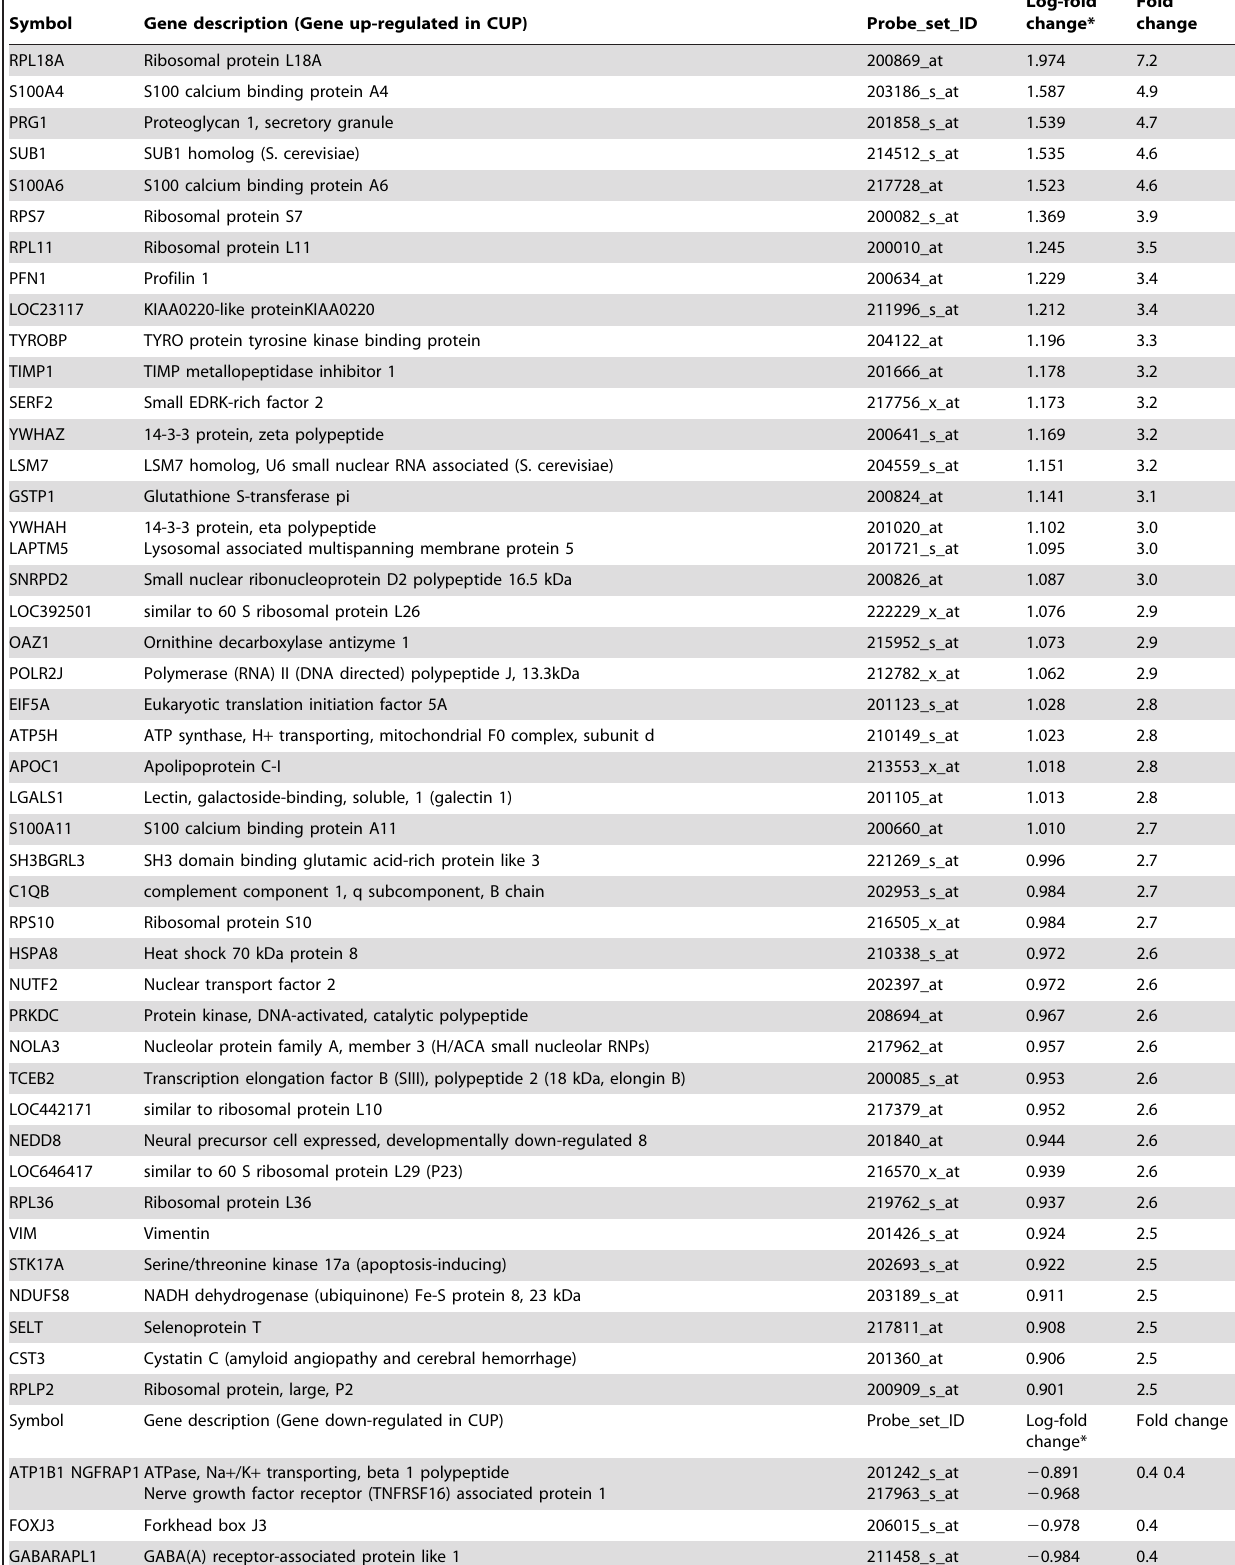
Table 2. Genes identified as being up-regulatred or down-regulated in CUP.